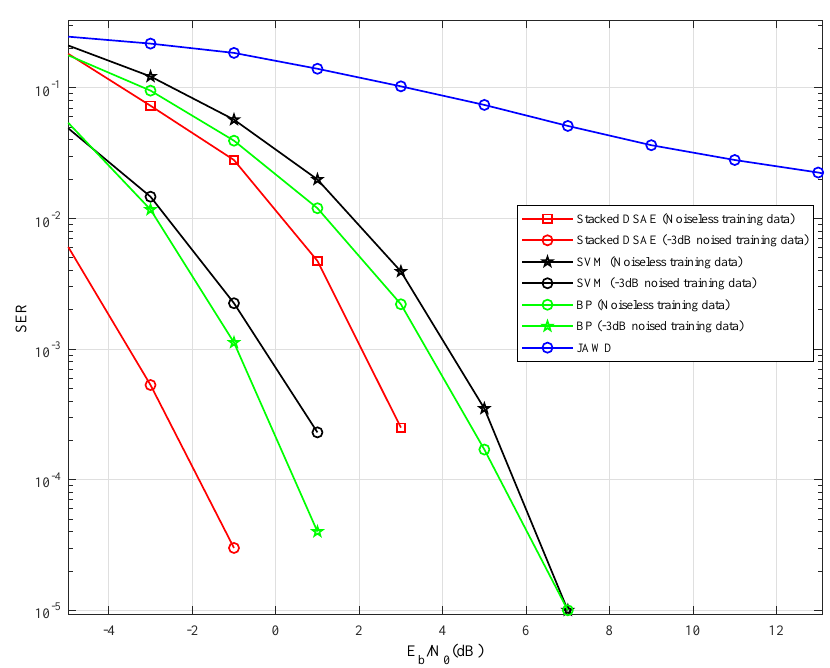
Figure 7. SER Comparisons of the improved 4PPSK system with various detection